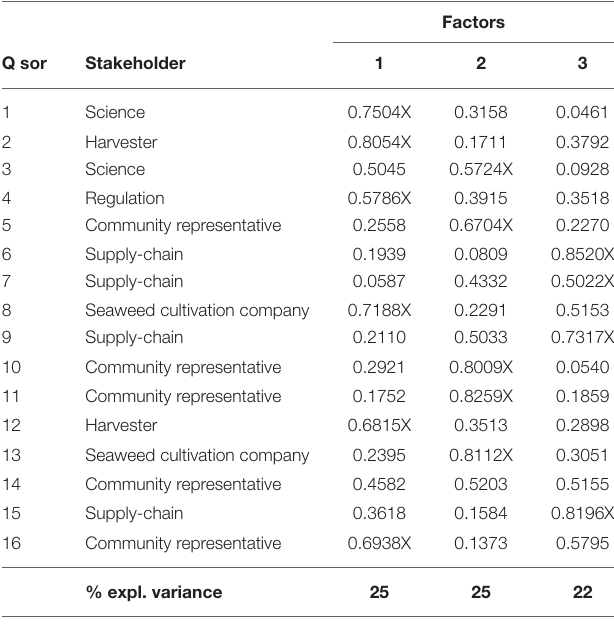
TABLE 4 | Factor matrix (Q sort results) where “X” indicates a defining sort using automatic flagging in PQ